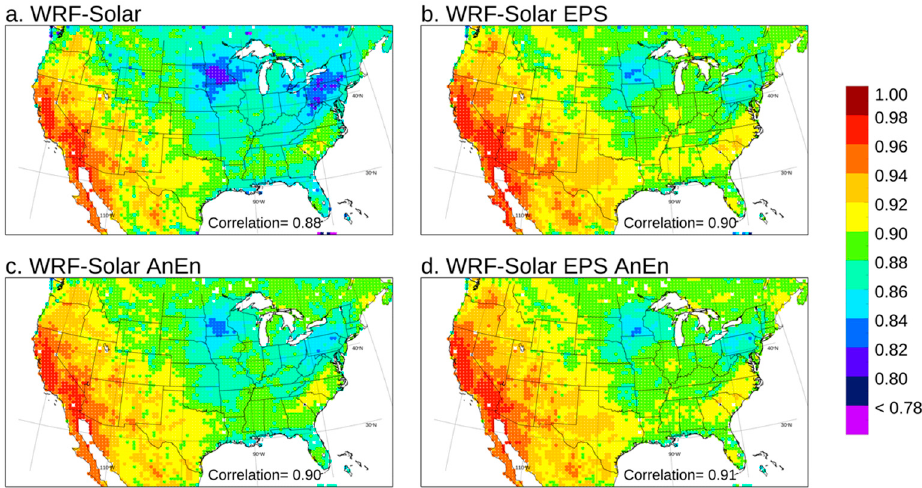
Figure 4. Pearson correlation computed for GHI over the year 2018 for the forecast lead times from +24 to +48 h. The value in the legend at the bottom of each panel indicates the correlation computed by pooling all the grid points and lead times together.